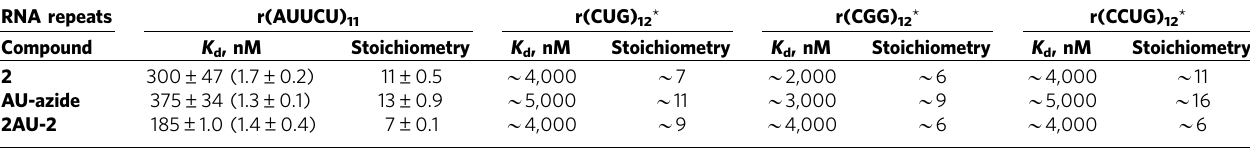
2AU-2 *The stoichiometry from unsaturated binding curves was estimated from data fit by equation (1). The K d was calculated by using the estimated